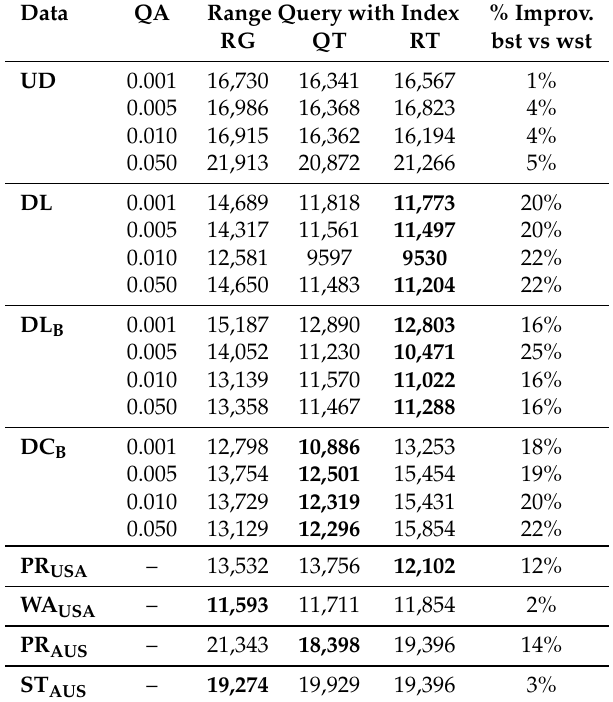
Table 5. Result of experiments with range queries. we performed experiments on each listed dataset, considering queries of size 0.001, 0.005, 0.01 and 0.05 w.r.t. a normalized reference space of 1 × 1. The reported time is in milliseconds and is an average value over about 200 queries for each case.